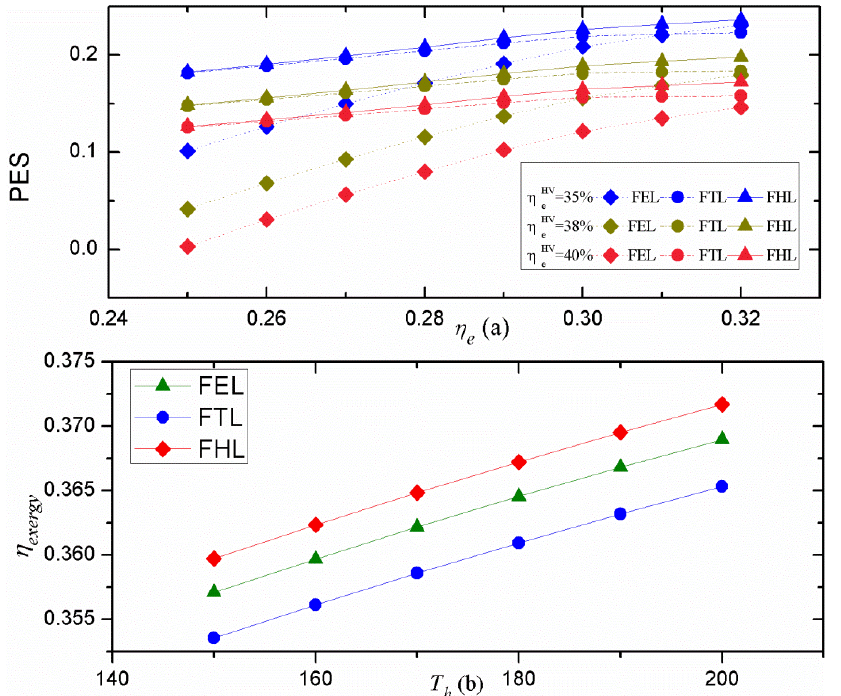
Figure 12. The sensitivity analysis of CCHP system based on simulated data in FEL, FTL and FHL